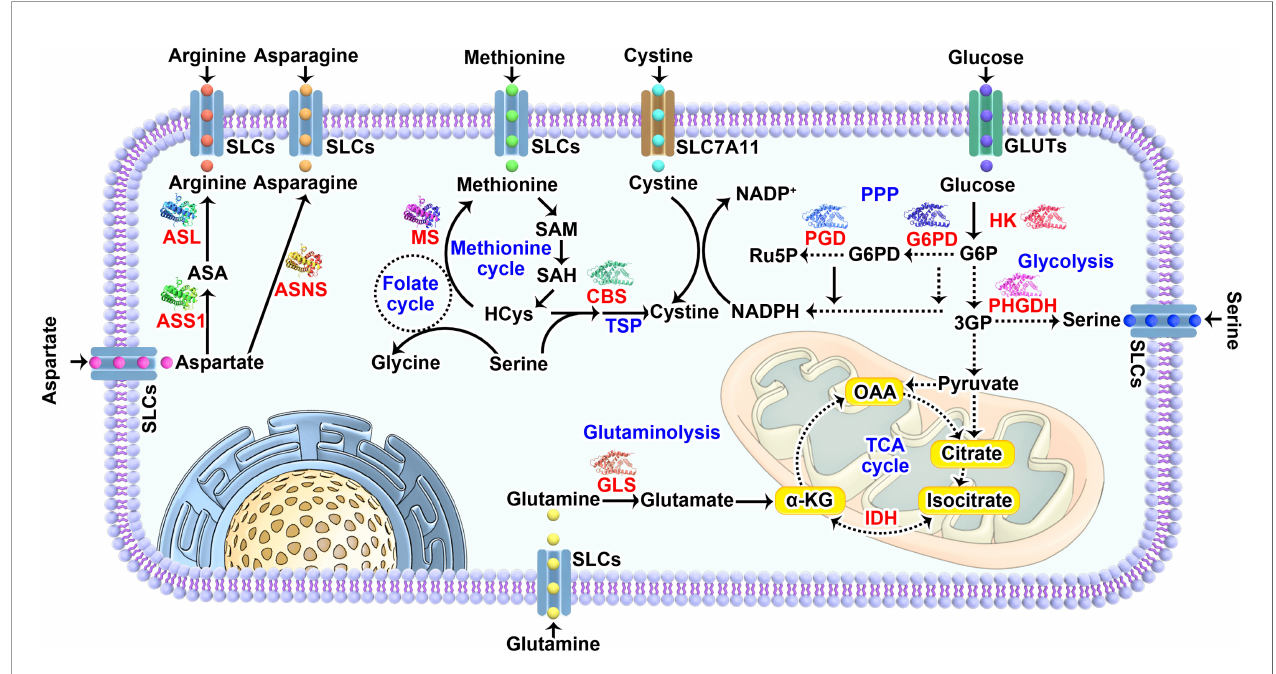
FIGURE 1 | Nutrients that frequently causing dependency in tumor cells. The major pathways and key enzymes (labeled in red) involved that modulating the dependency of discussed nutrients (labeled in purple) are summarized in the diagram. SLCs, solute carrier-type transporters; GLUTs, glucose transporters; ASS1, argininosuccinate Synthase 1; ASL, argininosuccinate lyase; ASNS, asparagine synthetase; MS, methionine synthase; CBS, cystathionine beta-synthase; PGD, phosphogluconate dehydrogenase; G6PD, glucose-6-phosphate dehydrogenase; HK, hexokinase; PHGDH, phosphoglycerate dehydrogenase; IDH, isocitrate dehydrogenase; GLS, glutaminase; TSP, transsulfuration pathway; PPP, pentose phosphate pathway; TCA cycle, the tricarboxylic acid cycle; HCys, homocysteine; NADPH, reduced nicotinamide adenine dinucleotide phosphate; G6P, glucose 6-phosphate; 3PG, 3-phosphoglycerate; 6PD, 6- phosphogluconate; Ru5P, ribulose 5-phosphate; OAA, oxaloacetate; a -KG, a